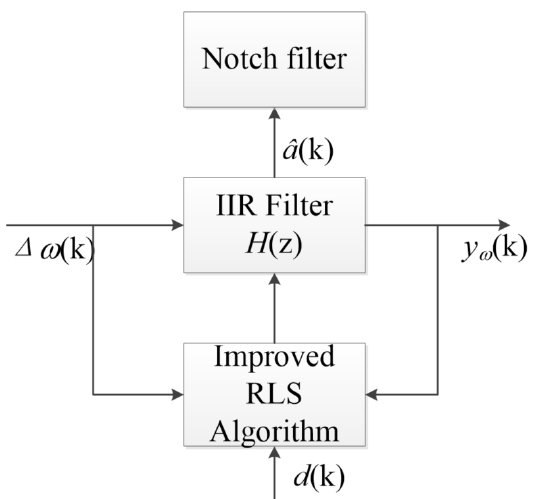
Figure 6. The adaptive notch filter structure diagram.